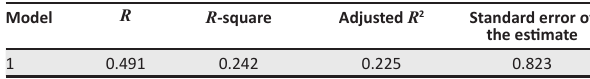
TABLE 3: Model summary of multiple regression.